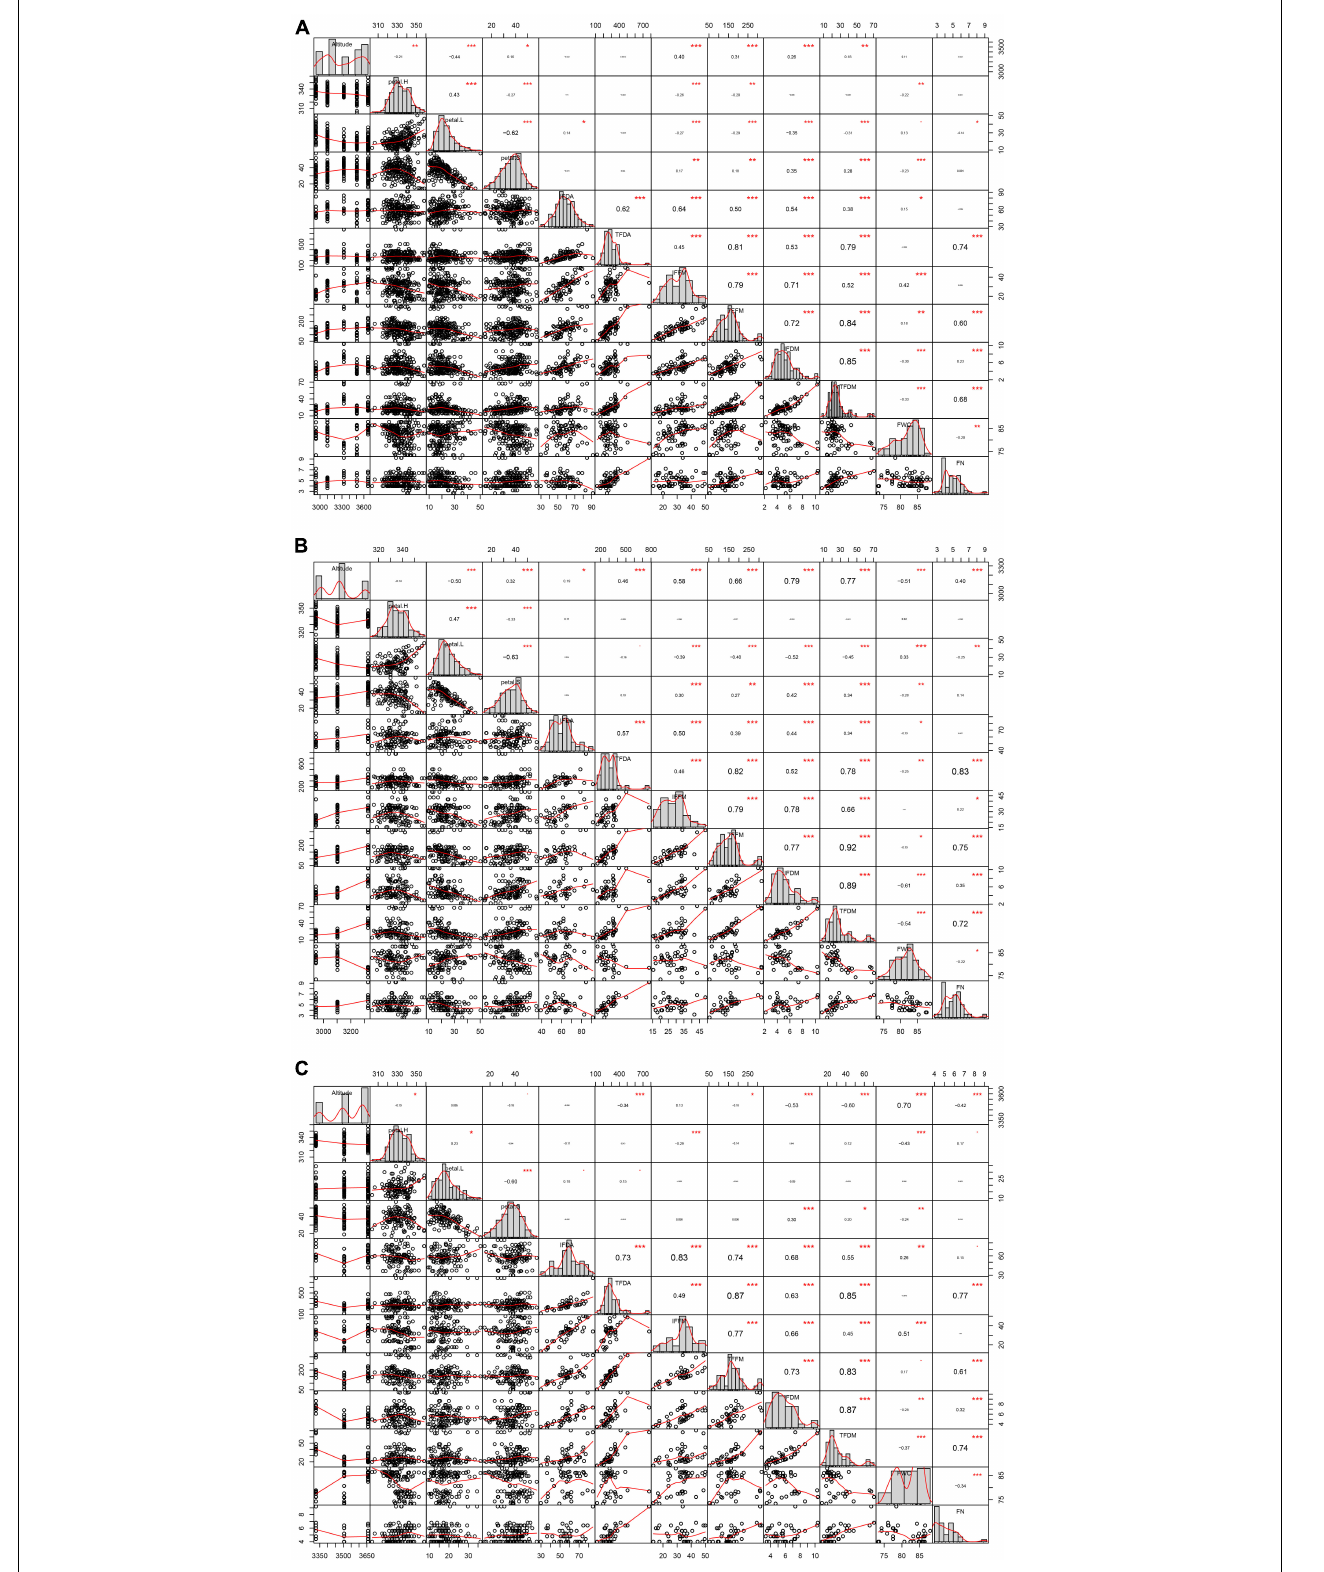
FIGURE 4 | Correlation among floral traits and color within different altitude ranges: (A) 2,950–3,650 m, (B) 2,950–3,300 m, and (C) 3,300–3,650 m.